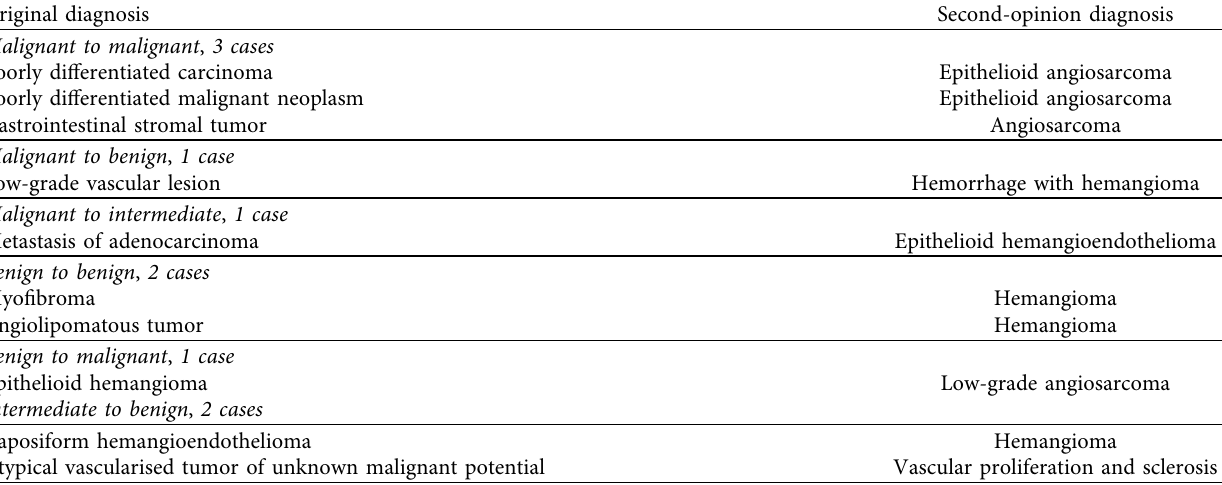
Table 5: Vascular tumors with discrepancy in opinion.